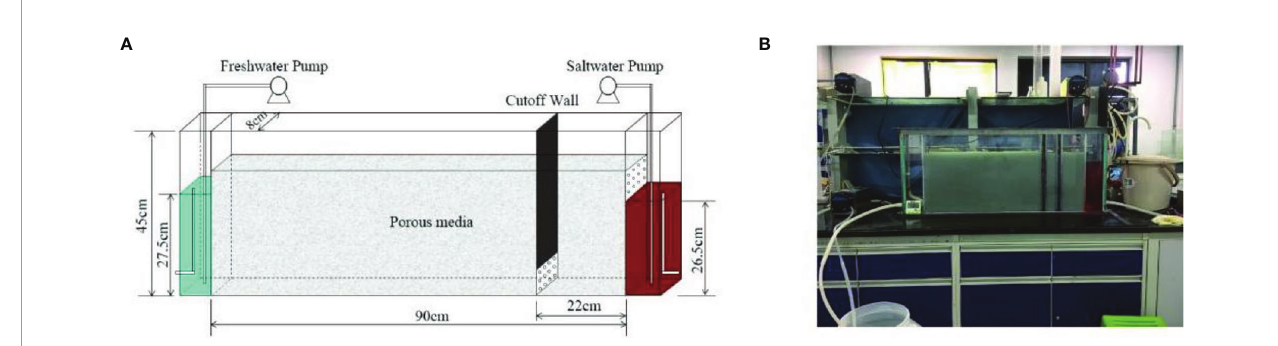
FIGURE 3 | The schematic (A) and photo (B) of the experimental setup (Gao et al.,